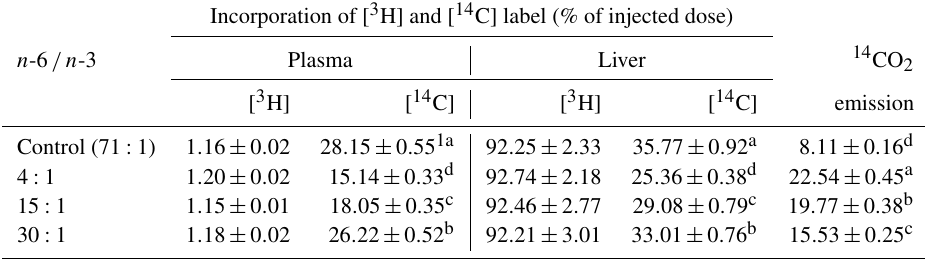
Table 3. 14 CO 2 emission and incorporation of [ 3 H] and [ 14 C] into liver and plasma at 60min after injection of LPS ( d < 1 . 019) labeled with cholesteryl [ 14 C] oleate in jugular-vein-cannulated rats. Incorporation of [ 3 H] and [ 14 C] label (% of injected dose)